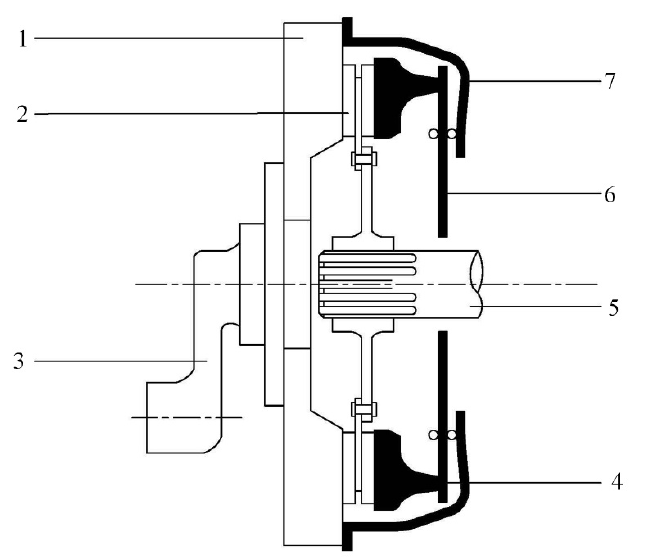
Figure 5. Diagram of typical dry clutch. 1: Fly wheel; 2: Clutch disk; 3: Crank shaft; 4: Input shaft; 5: Diaphragm; 6: Pressure plate; 7: Cover.